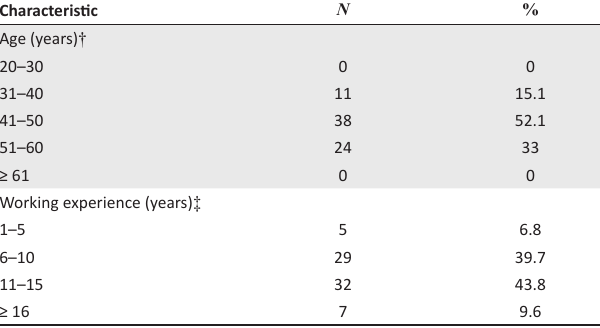
TABLE 2: Demographic characteristics of the miners ( N = 73).